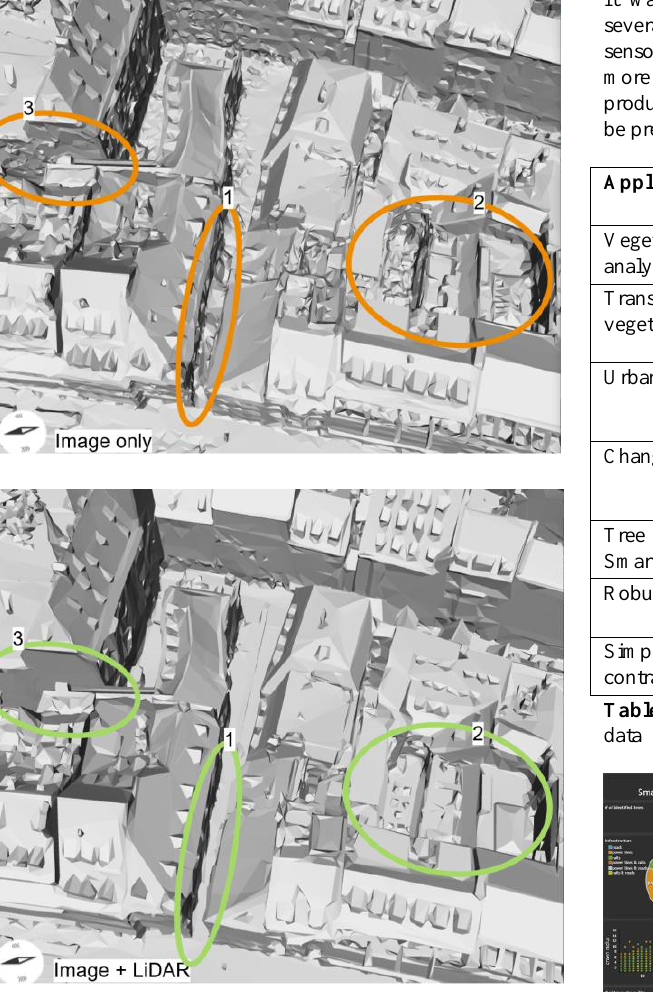
Figure 14: Comparison of 3D Mesh from image only (top) and image + LiDAR (below) approach. 3D mesh generated by Melown technologies from CityMapper-2 data, 5 cm GSD